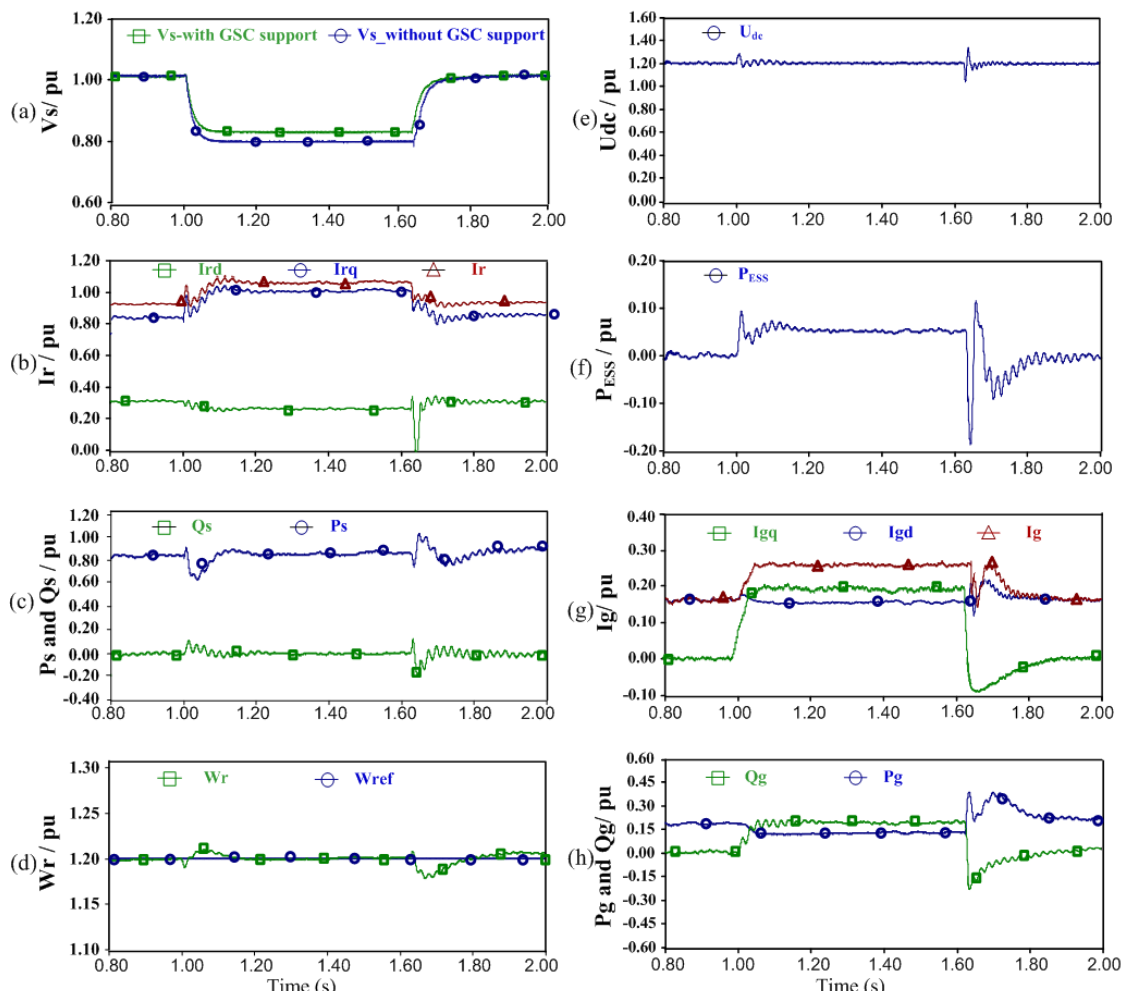
Figure 14. Maximum power production of the DFIG-ESS during voltage dips: ( a ) terminal voltage; ( b ) current of RSC; ( c ) output power of the stator; ( d ) generator speed; ( e ) DC-link voltage; ( f ) active power of the ESS; ( g ) current of GSC; and ( h ) output power of the